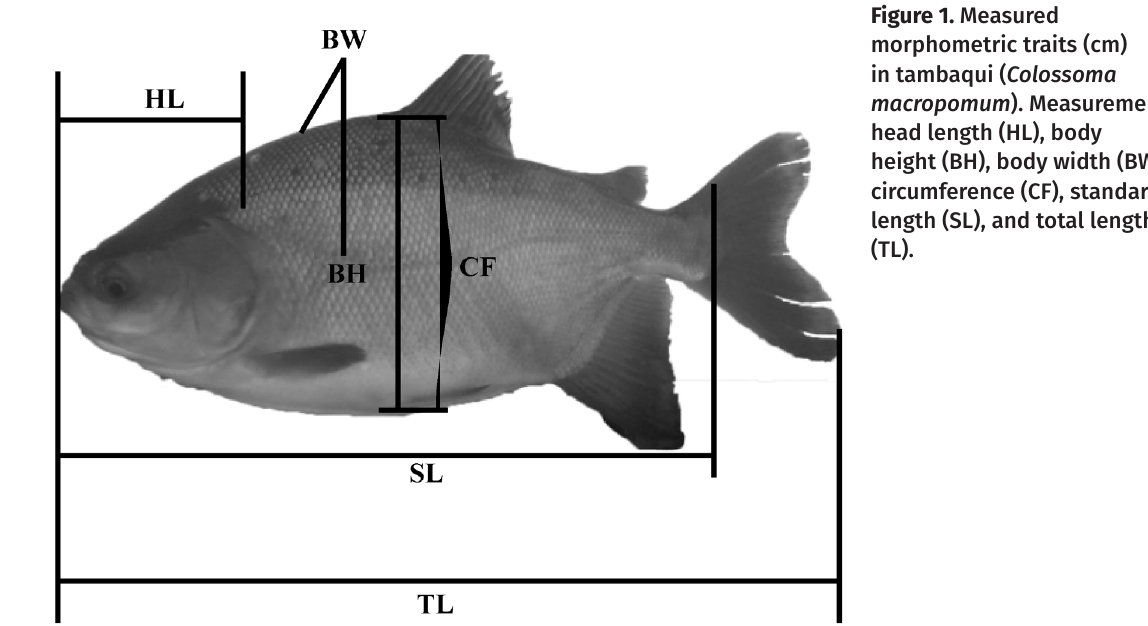
Figure 1. Measured morphometric traits (cm) in tambaqui (